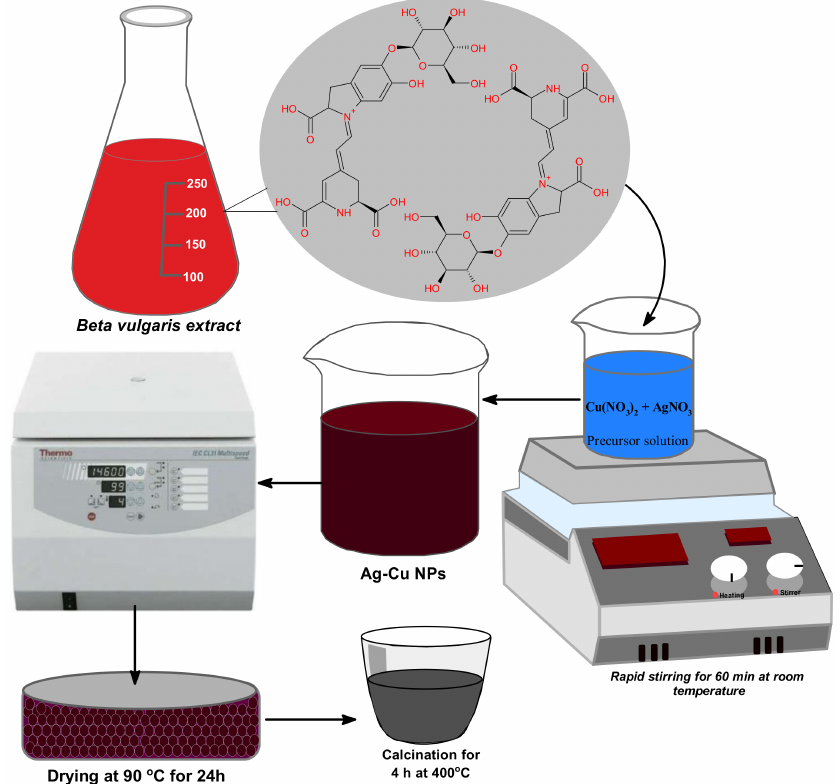
Figure 2. Schematic representation of Beta vulgaris assisted synthesis of Ag-Cu bimetallic nanoparticles.